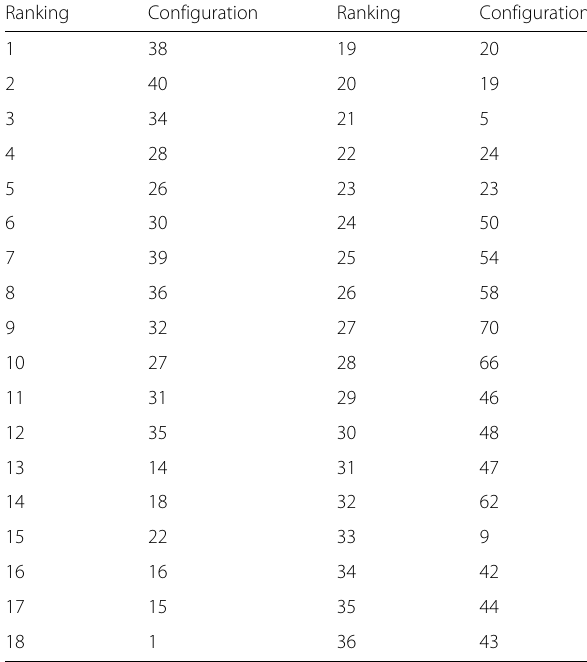
Table 10 Configurations ranking for the defined criteria (i.e. minimize cost and maximize coa) Ranking Configuration Ranking Configuration